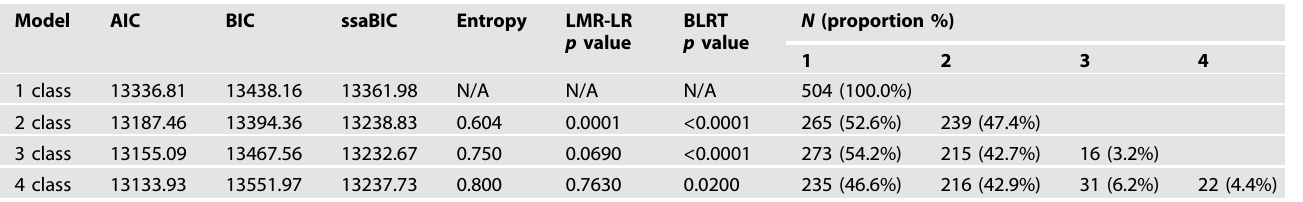
Table 2. Comparisons of fi t indices of latent class analysis ( n =